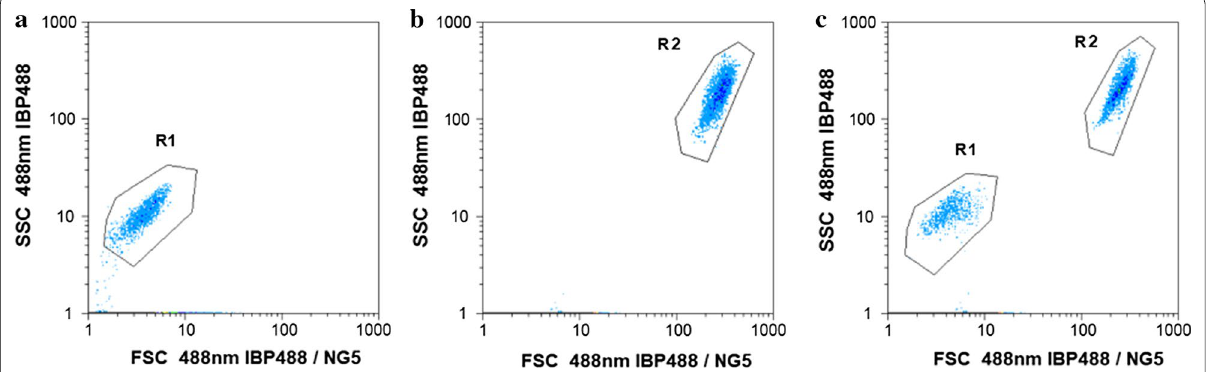
Fig. 1 Identification of B. coagulans and C. utilis with flow cytometer. a B. coagulans. b C. utilis . c Both B. coagulans and C. utilis